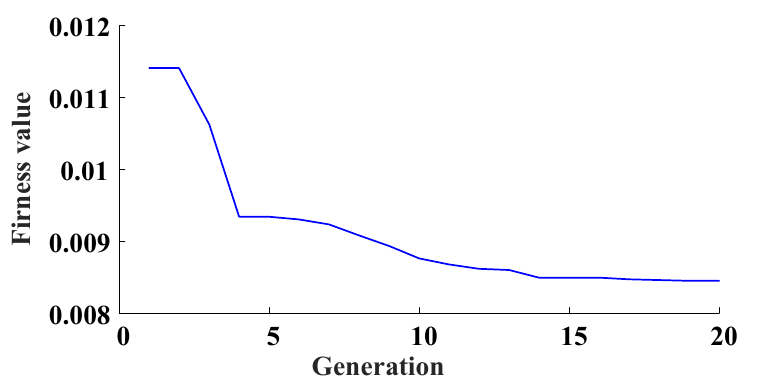
Figure 4. Evolution of the NMSE in terms of generation.